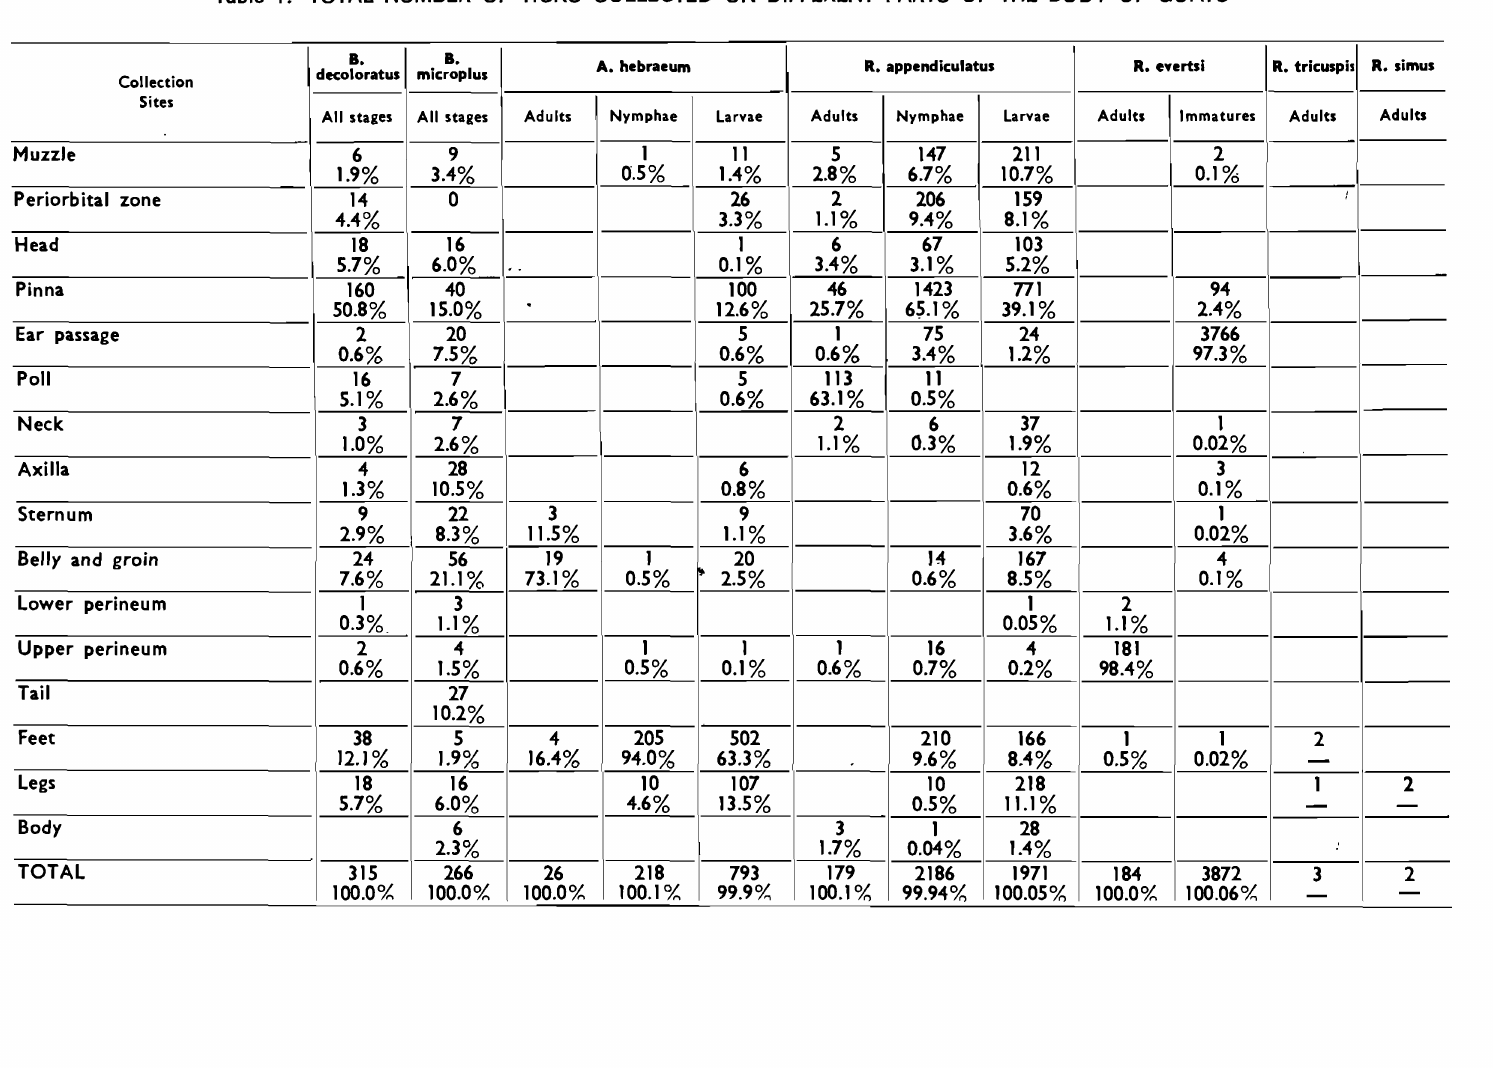
Table 1: TOTAL NUMBER OF TICKS COLLECTED ON DIFFERENT PARTS OF THE BODY OF GOATS